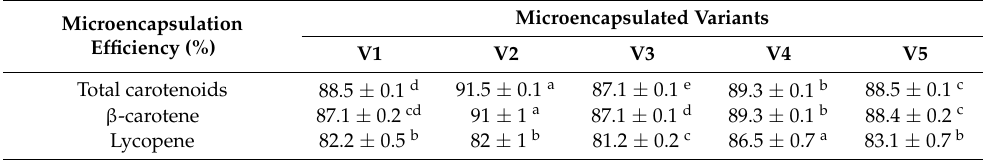
Table 2. Encapsulation efficiency of the selected phytochemicals in microencapsulated